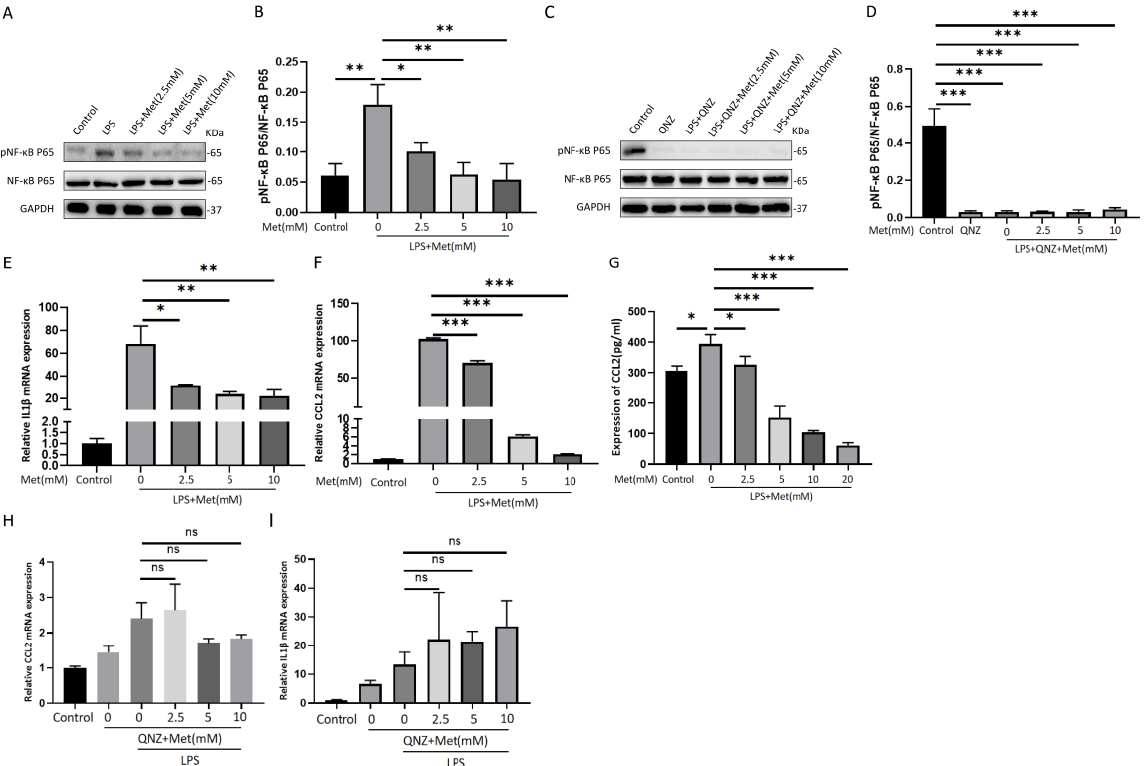
Figure 8. Metformin − mediated reduction in phospho − NF − κ B and IL1 β and CCL2 is abolished by treatment with QNZ, an inhibitor of NF − κ B. ( A , B ) Western blots showing the effect of metformin pretreatment on the expression of pNF − κ B and NF − κ B in RAW 264.7 cells. Densitometry analysis of Western blotting results. ( C , D ) Protein expression of pNF − κ B and NF − κ B in RAW 264.7 cells after QNZ and metformin preintervention is quantified in the histogram. ( E , F ) Changes in mRNA expression of IL1 β and CCL2 in RAW 264.7 cells stimulated by LPS after pretreatment with different doses of metformin. ( G ) ELISA showing the effect of metformin on CCL2 expression in RAW 264.7 cells. ( H , I ) Changes in mRNA expression of IL1 β and CCL2 in RAW 264.7 cells stimulated by LPS after pretreatment with QNZ and various doses of metformin. All experiments were repeated three times and means ± SDs of the data are shown ( n = 3). ns: no significance. * p <0.05, ** p < 0.01, and *** p < 0.001. Control: RAW 264.7 cells, QNZ: RAW 246.7 cells pretreated with QNZ, LPS + Met (mM): pretreatment with metformin followed by LPS intervention, LPS + QNZ + Met (mM): pretreatment with metformin and QNZ, followed by LPS